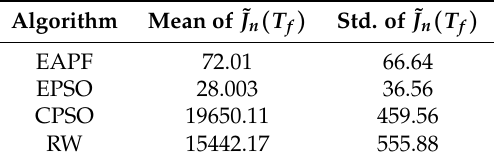
Figure 2. Approximated cost functions for different path-planning algorithms in the indoor environment, where the solid lines represent the mean of the approximated cost values over all the robots at the k th time step and the dashed lines indicate one standard deviation above and below the solid lines. Table 1. Statistical results of the approximated cost function at the final time step in the indoor environment.